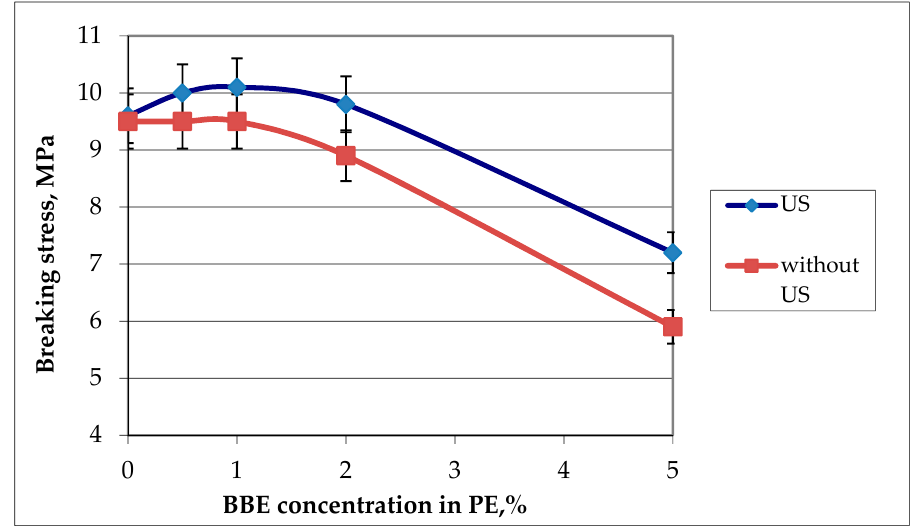
Figure 5. Graphic dependence of the breaking stress on the birch bark extract (BBE) content in polyethylene (PE) and on ultrasonic (US) treatment.